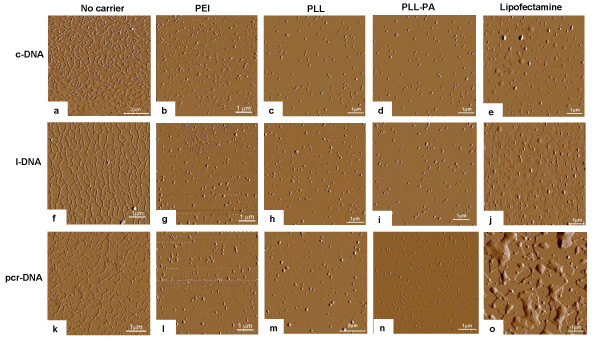
Tapping mode atomic force microscope amplitude topography of the three DNA molecules complexed with various gene carriers. All images were captured at a scan size of 6 × 6 μm, except where noted. c-DNA without carriers [8 × 8 μm] (a), with PEI (b), PLL (c), PLL-PA (d), and Lipofectamine-2000™ (e). l-DNA without carriers (f), with PEI (g), PLL (h), PLL-PA (i), and Lipofectamine2000™ (j). pcr-DNA without carriers [5 × 5 μm] (k), with PEI (l), PLL (m), PLL-PA (n), and Lipofectamine-2000™ (o).